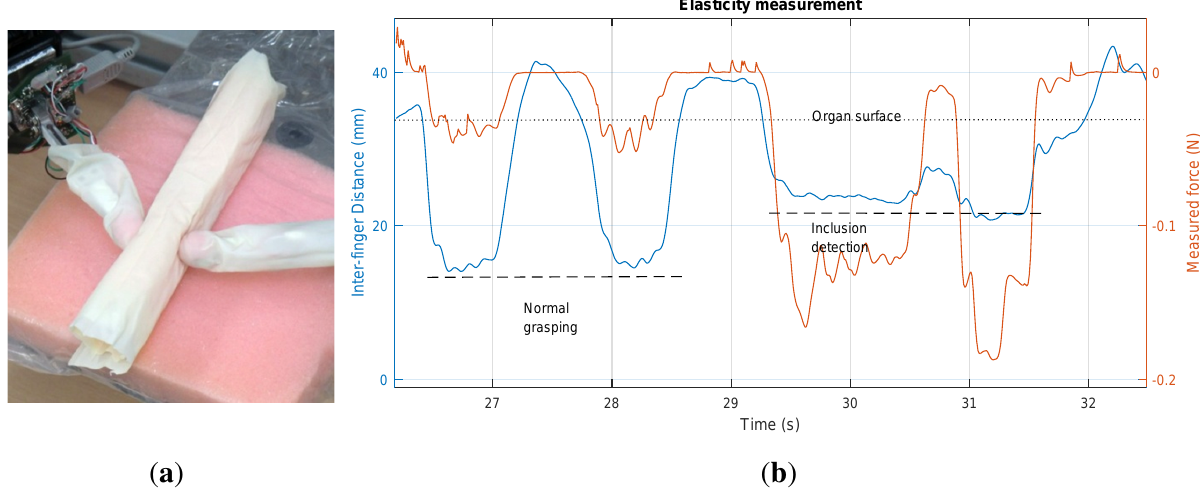
Figure 7. Physical gripper with force sensors performing the intraoperative diagnostic procedure on a physical model of the patient’s organ. ( a ) Physical model of the soft tissue (phantom); ( b ) distance between the centres of the fingertips and measured forces in one finger are shown. The left half shows normal contact. The right half shows the detection of a hard